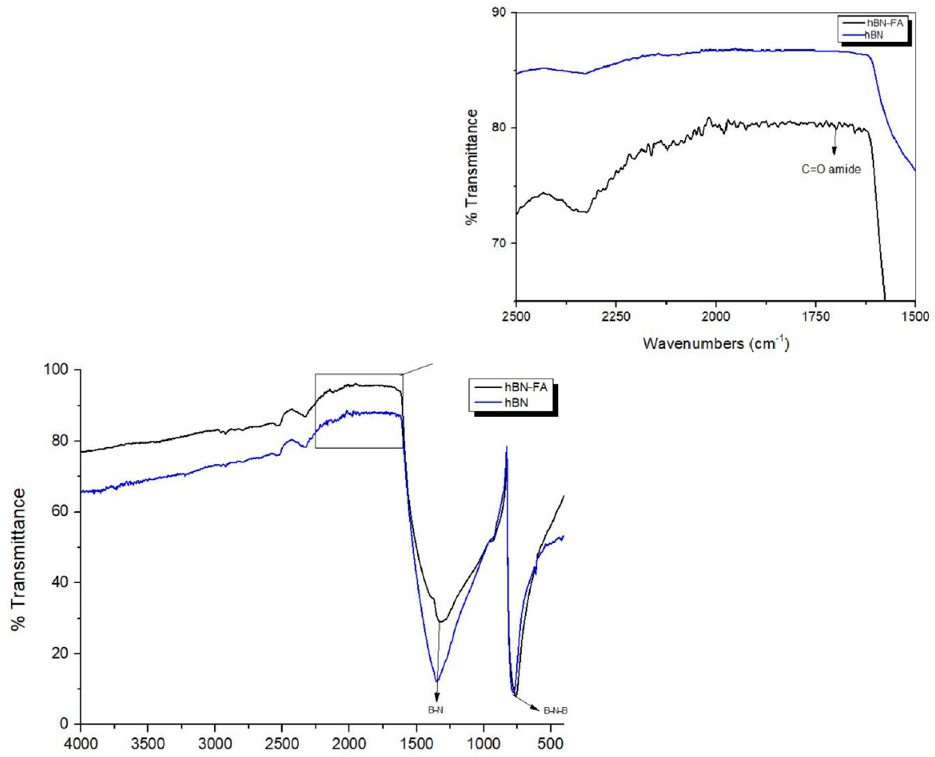
Figure 6. FTIR spectra of hBN and hBN-FA.